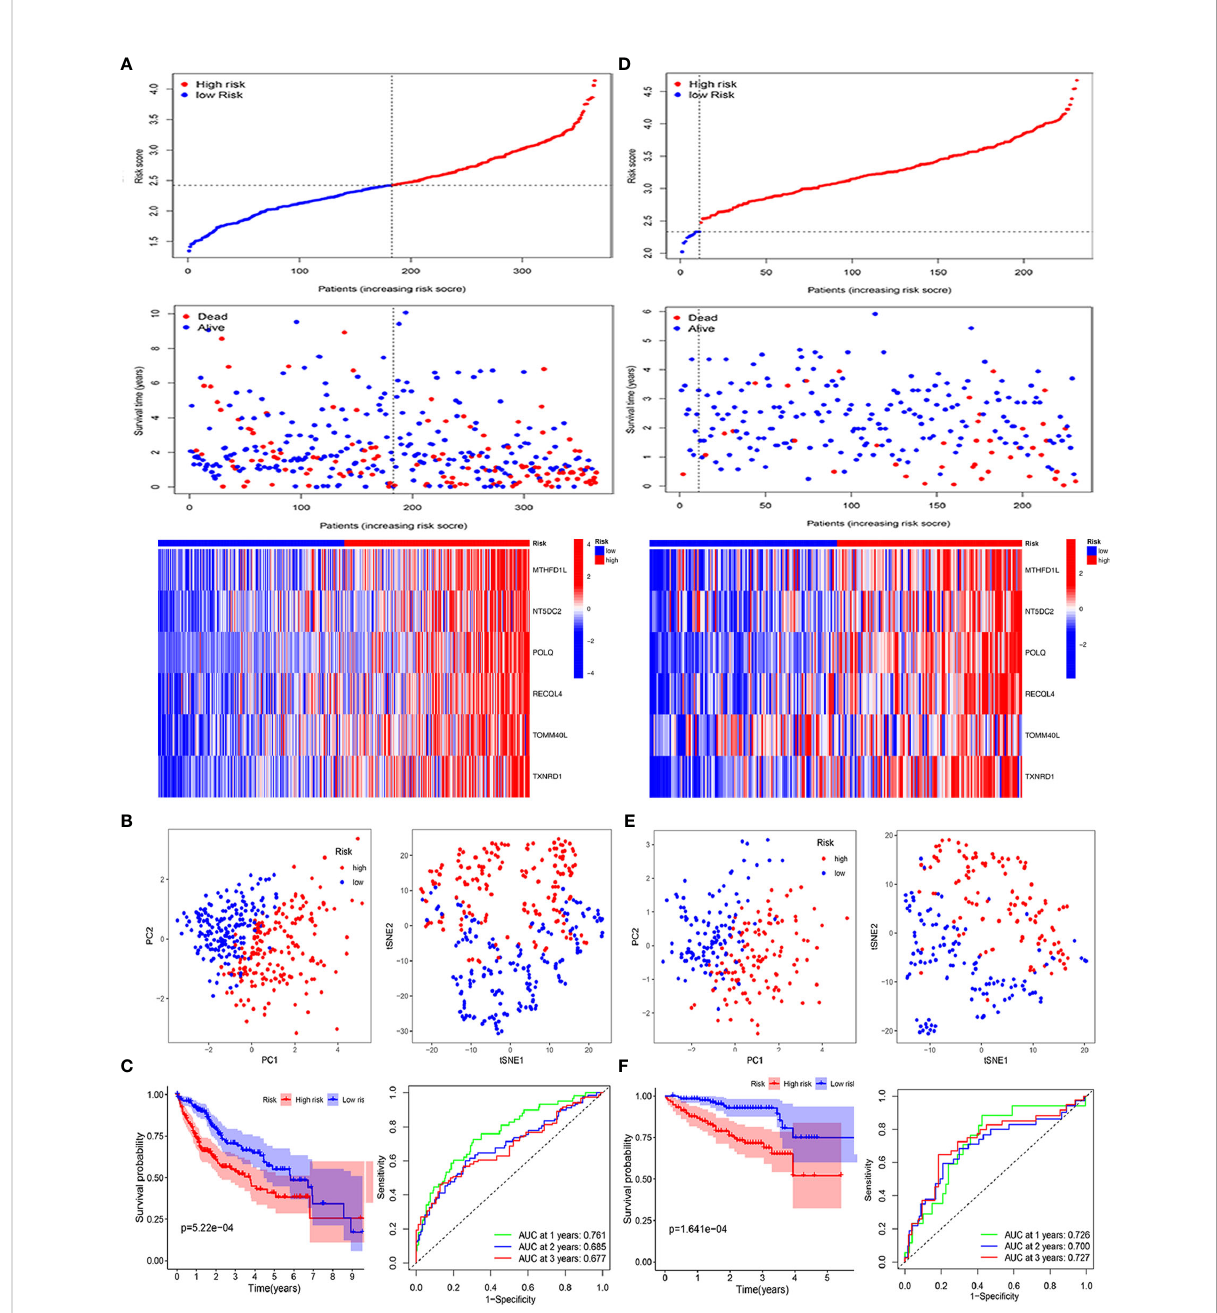
FIGURE 2 Validation of the six mitochondria-related prognostic signatures in the TCGA and ICGC cohorts. TCGA cohort: (A – C) ; ICGC cohort: (D – F) . (A – D) Risk score values and distribution, OS status and heatmap analysis of the 6-gene signature model. (B, E) The PCA plots and t-SNE analysis of risk scores. (C, F) Kaplan – Meier curves and AUC time-dependent ROC curves for